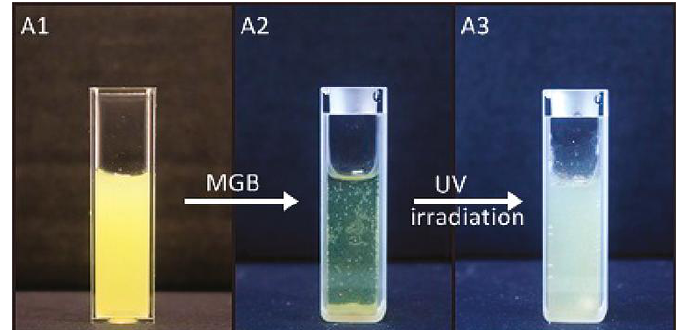
Figure 5. Light triggered reversible co-flocculated a mixed microgel system (reproduced with permission from reference